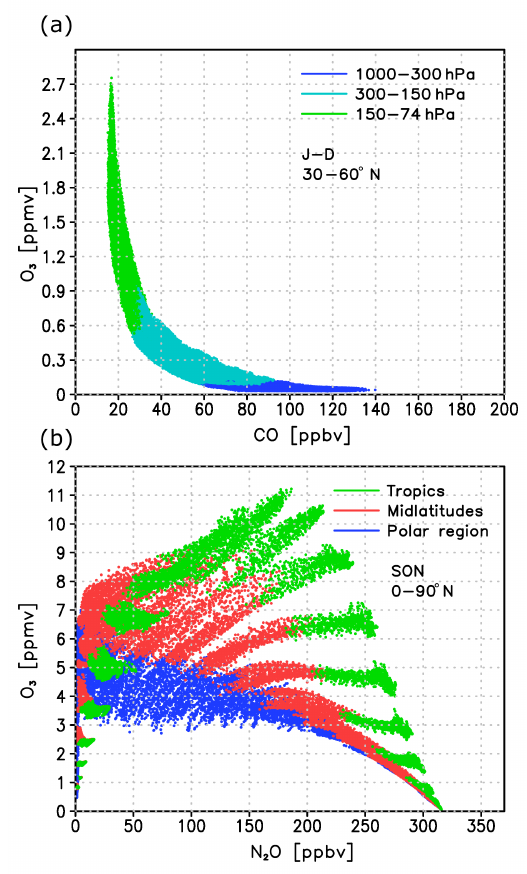
Figure 1. (a) O 3 –CO scatter plot for January to December in the latitude band 30–60 ◦ N for the REF2000 simulation from the tro- posphere to the lower stratosphere. Color coding indicates different height regions. (b) O 3 –N 2 O scatter plot for September to Novem- ber in the Northern Hemisphere for the REF2000 simulation at the altitude region between 270 and 0.1hPa. Color coding indicates dif- ferent latitude